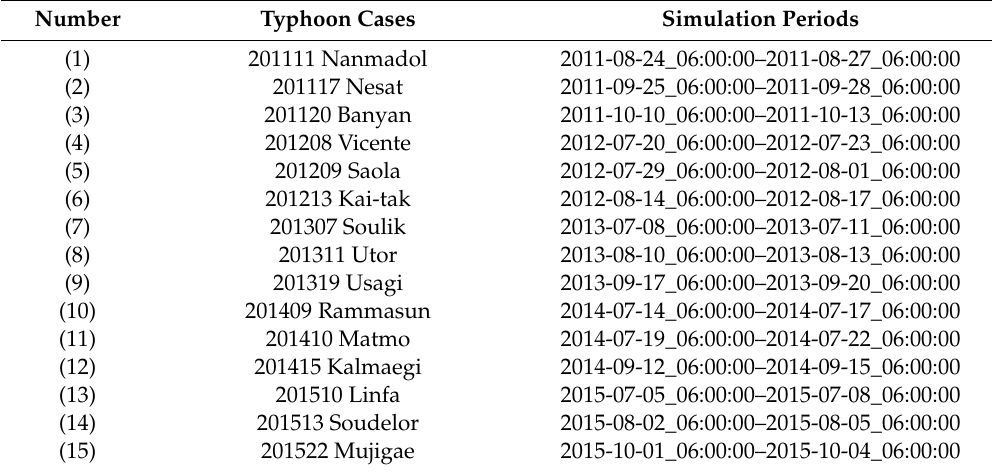
Table 1. Summary of the 15 simulated typhoon cases, including the typhoons’ Chinese number ID, names, and simulation periods